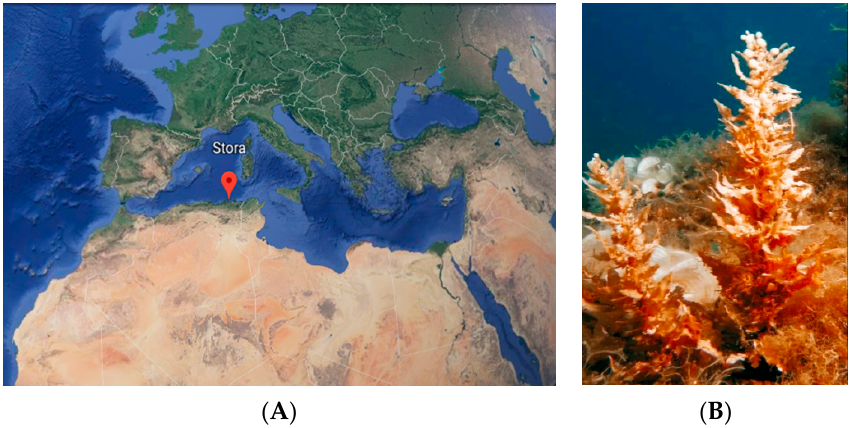
Figure 1. Overall illustration of sampling site at Stora, Skikda, Algeria, 36°53 ′ 54.9 ″ N, 6°52 ′ 48.1 ″ E ( A ) and S. vulgare ( B ). ( A ) and S. vulgare ( B